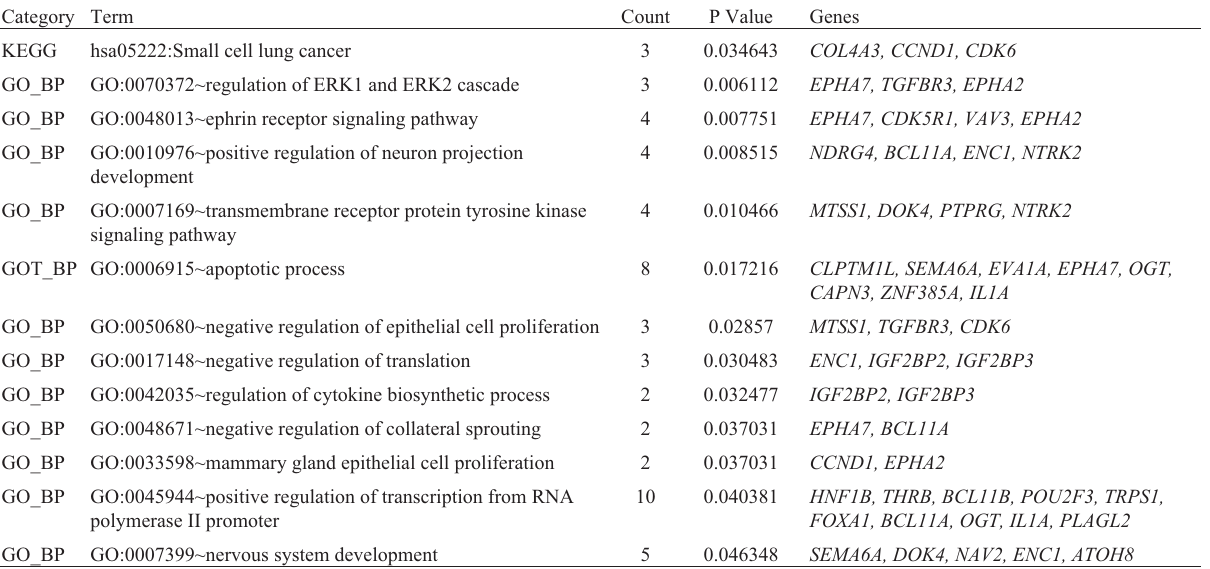
Table 4 - The functional enrichment analysis of DEmRNAs in ceRNA network.